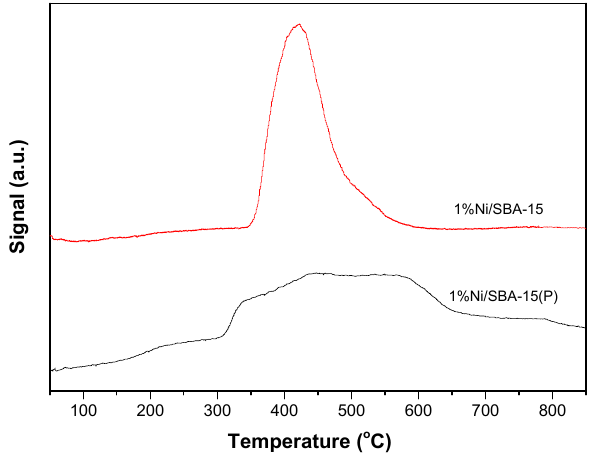
Figure 4. H 2 -TPR profile of the fresh 1%Ni/SBA-15 and 1%Ni/SBA-15(P) catalysts.